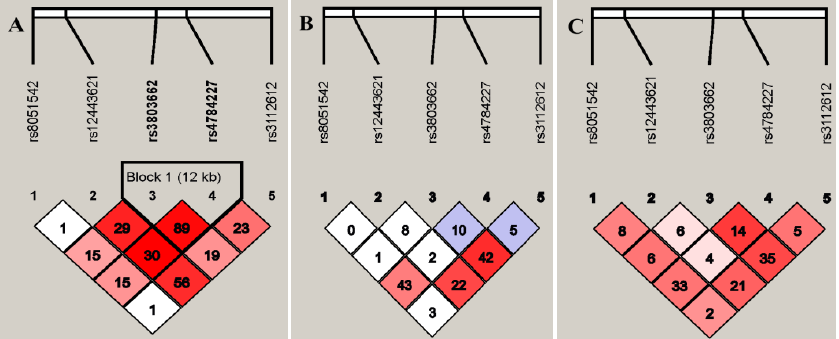
Figure 1. Linkage disequilibrium patterns among five SNPs in 16q12.1. The r 2 values were presented; ( A ) the HapMap CEU population; ( B ) the HapMap CHB population; ( C ) Our